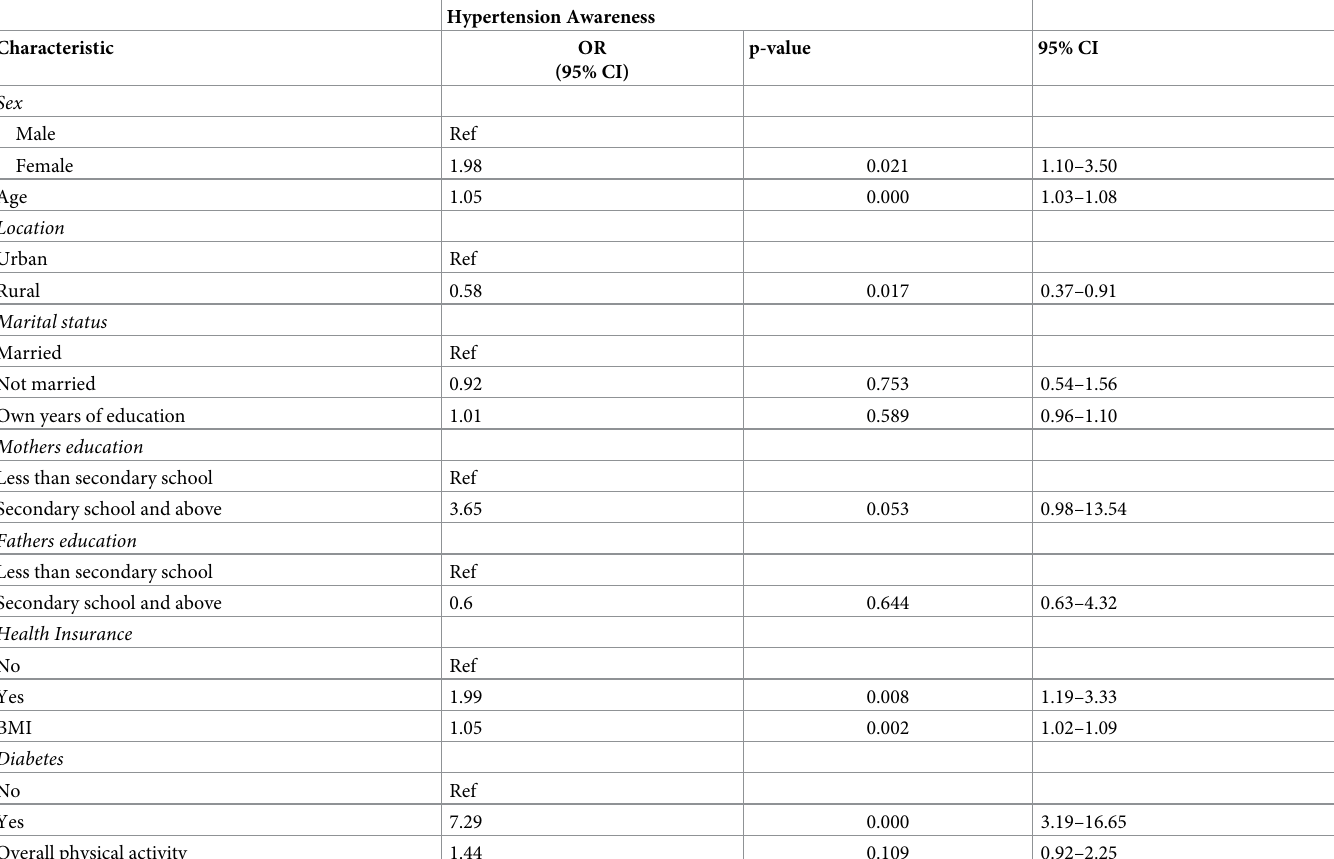
Table 3. Odds ratio showing the predictors of change in hypertension awareness (WHO-SAGE Ghana Waves 1 and 3), n =